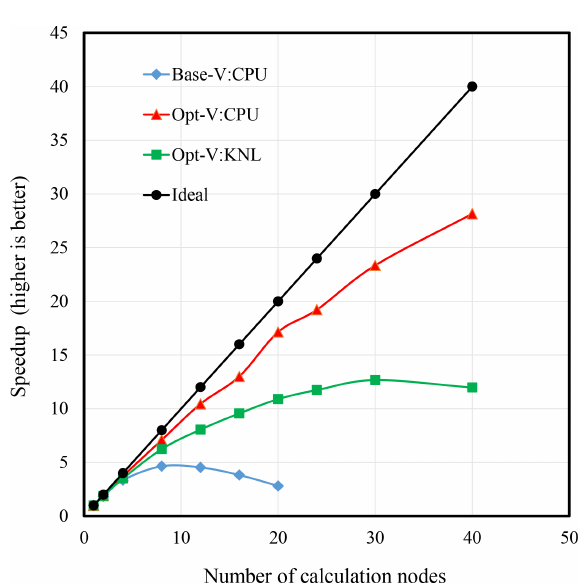
Figure 6. Scalability of Base-V and Opt-V GNAQPMS on the CPU and KNL clusters. Base-V GNAQPMS on the CPU cluster had a bad scalability and its performance was nearly saturated on 8 nodes, whereas Opt-V GNAQPMS could reach at least 40 nodes on the CPU and at most 30 nodes on